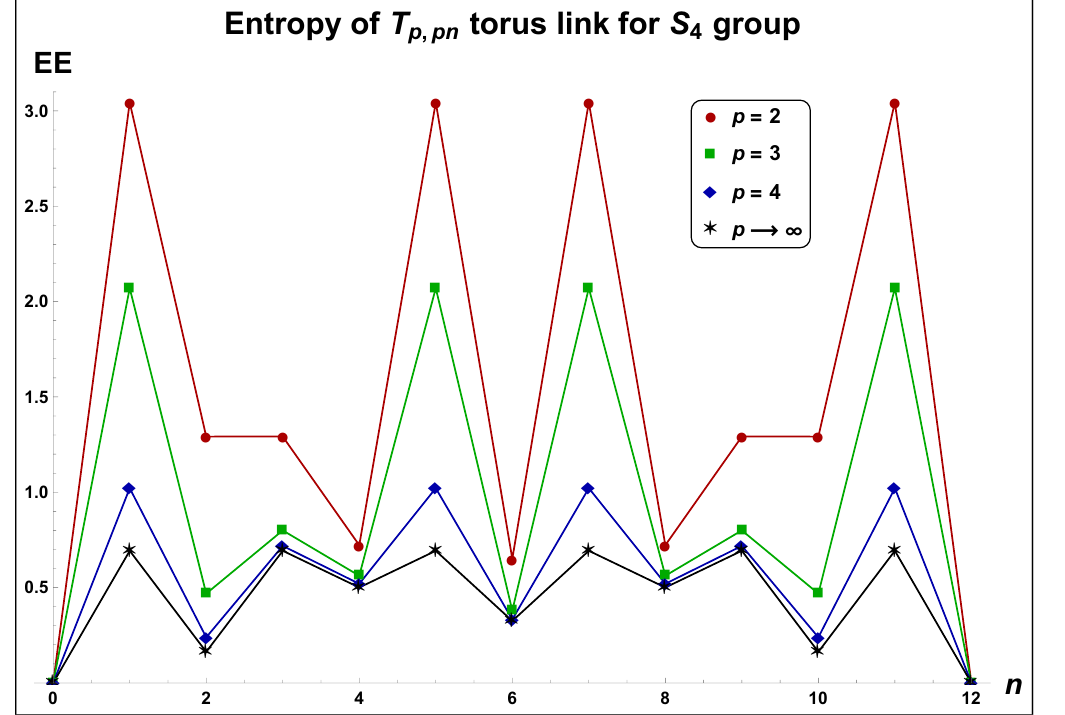
Figure 7 . The variation of entropy of j T p;pn i states computed for the S 4 group. The entropy (cid:13)uctuates as n increases and reaches maximum and minimum values according to eq. (4.55). We also show the entropy of j T p;pn i state as p ! 1